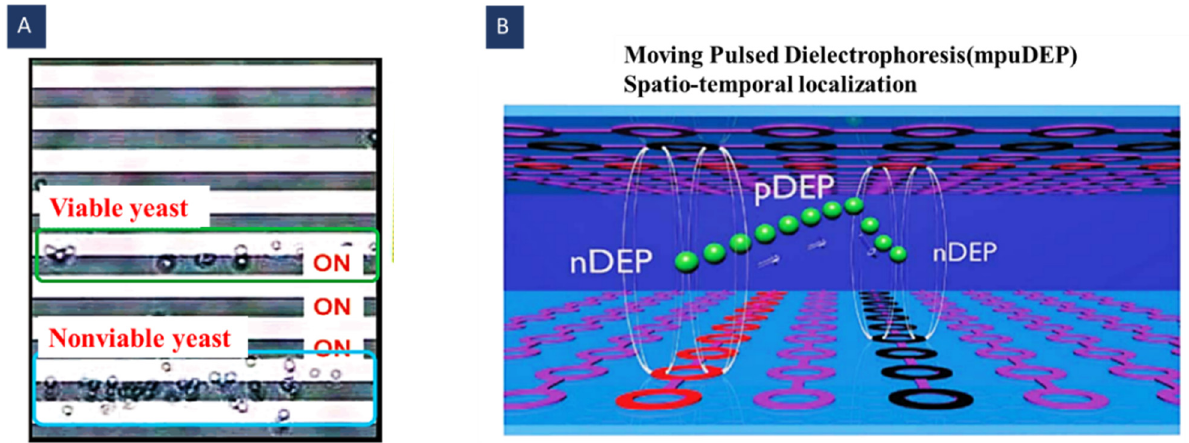
Figure 10. Using mDEP for cell/particle manipulation; ( A ) separation of viable and nonviable cells based on their different dielectric properties (Reprinted with permission from [73]. Copyright 2007, American Chemical Society(ACS) Publications); ( B ) using moving pulsed DEP for contactless and addressable particle manipulation (Reprinted with permission from [74]. Copyright 2013, Royal Society of